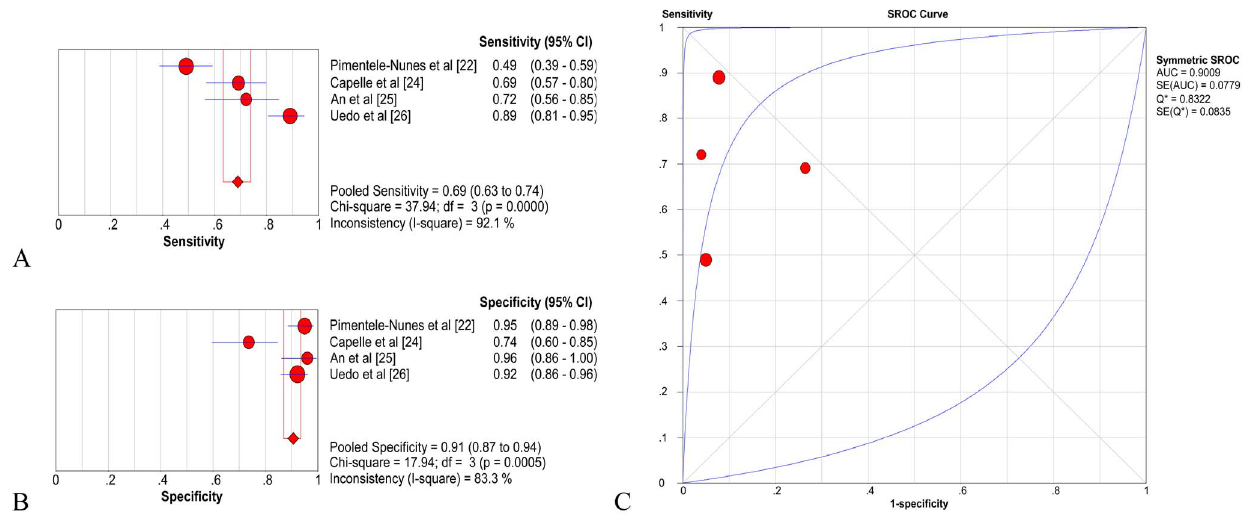
Figure 4. Gastric intestinal metaplasia (GIM), per-lesion analysis of diagnostic performance of narrow band imaging (NBI). A. Pooled sensitivity for NBI to differentiate GIM; B. Pooled specificity for NBI to differentiate GIM; C. The summary receiver operating characteristic (SROC) cure for diagnosis by NBI. CI, confidence interval; df, degrees of freedom; AUC, area under curve; SE, standard error.